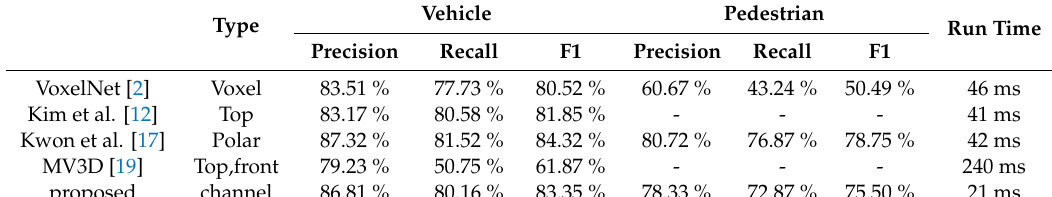
Table 1. Results of 16-channel LiDAR object detection.